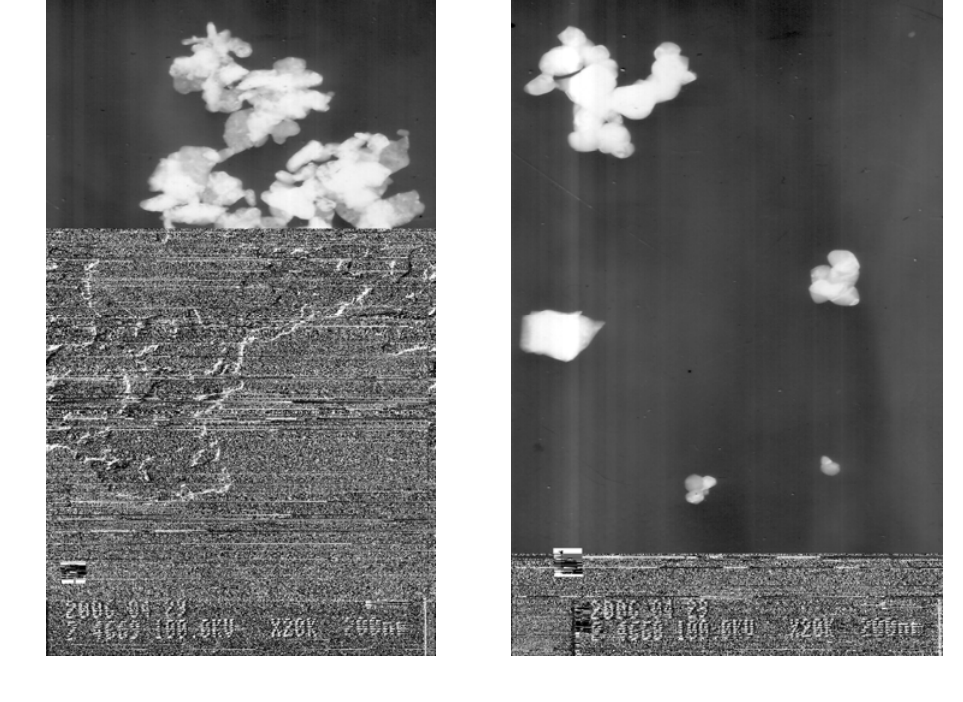
Figure 11. Effect of number of Ag